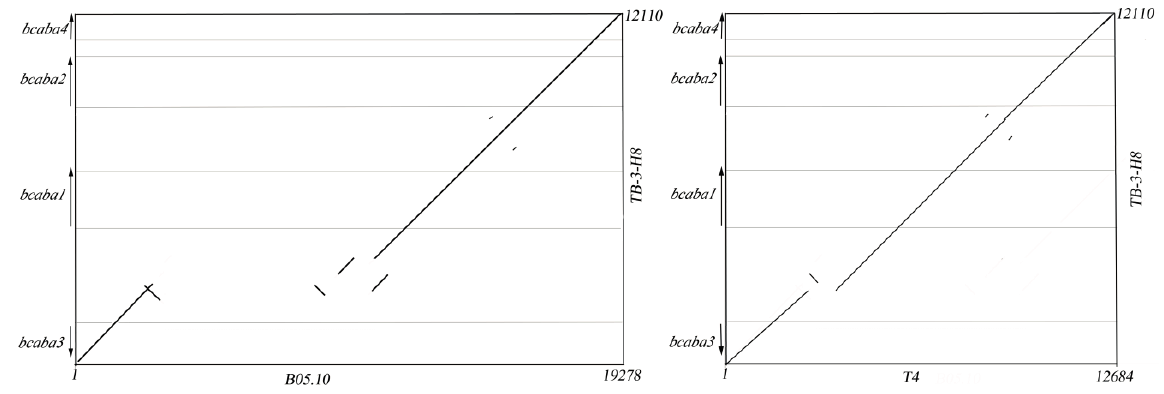
Figure 4. Comparative dot plot analysis of the ABA cluster in B . cinerea B05.10 ( A ) and T4 ( B ) with respect to the TB-3-H8 strain.